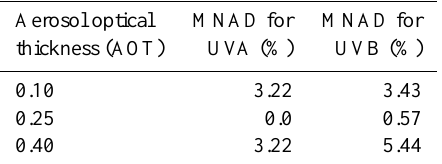
Table 3. Mean normalised absolute difference (MNAD) for UVA and UVB irradiance under varying aerosol optical thickness (AOT) values. Aerosol optical MNAD for MNAD for thickness (AOT) UVA (%) UVB (%) 0.10 3.22 3.43 0.0